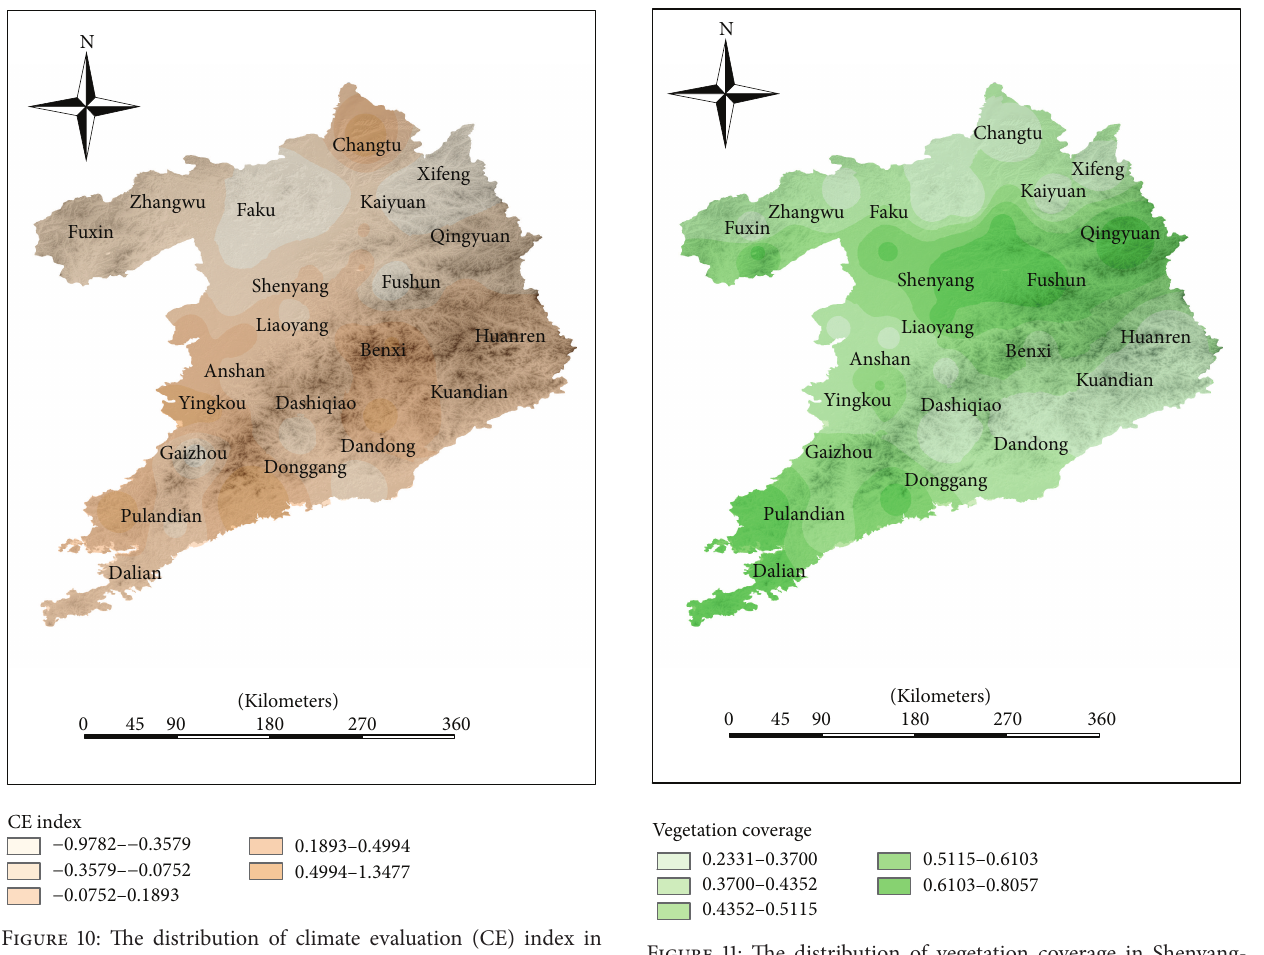
Figure 11: The distribution of vegetation coverage in Shenyang- Dalian urban